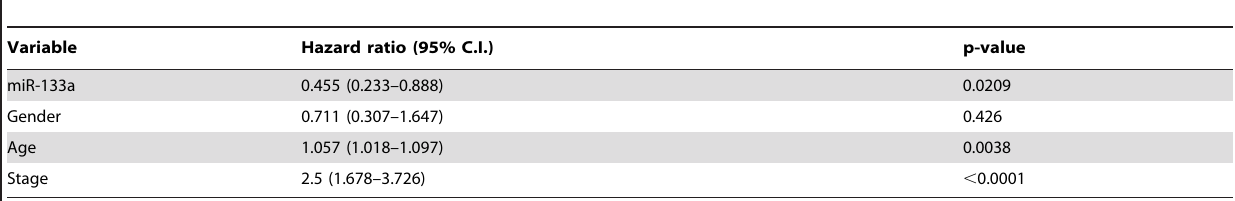
Table 1. Multivariable Cox regression analysis of miR-133a levels and overall survival in 112 NSCLC patients.